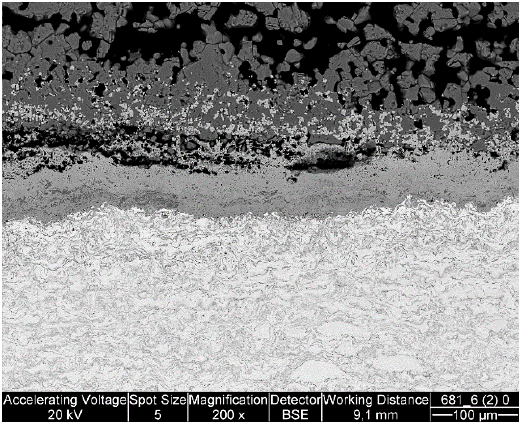
Figure 8. SEM image of the HVOF DJ Hybrid sprayed FeNiCrAl coating cross-section after the exposure at 650 °C for 700